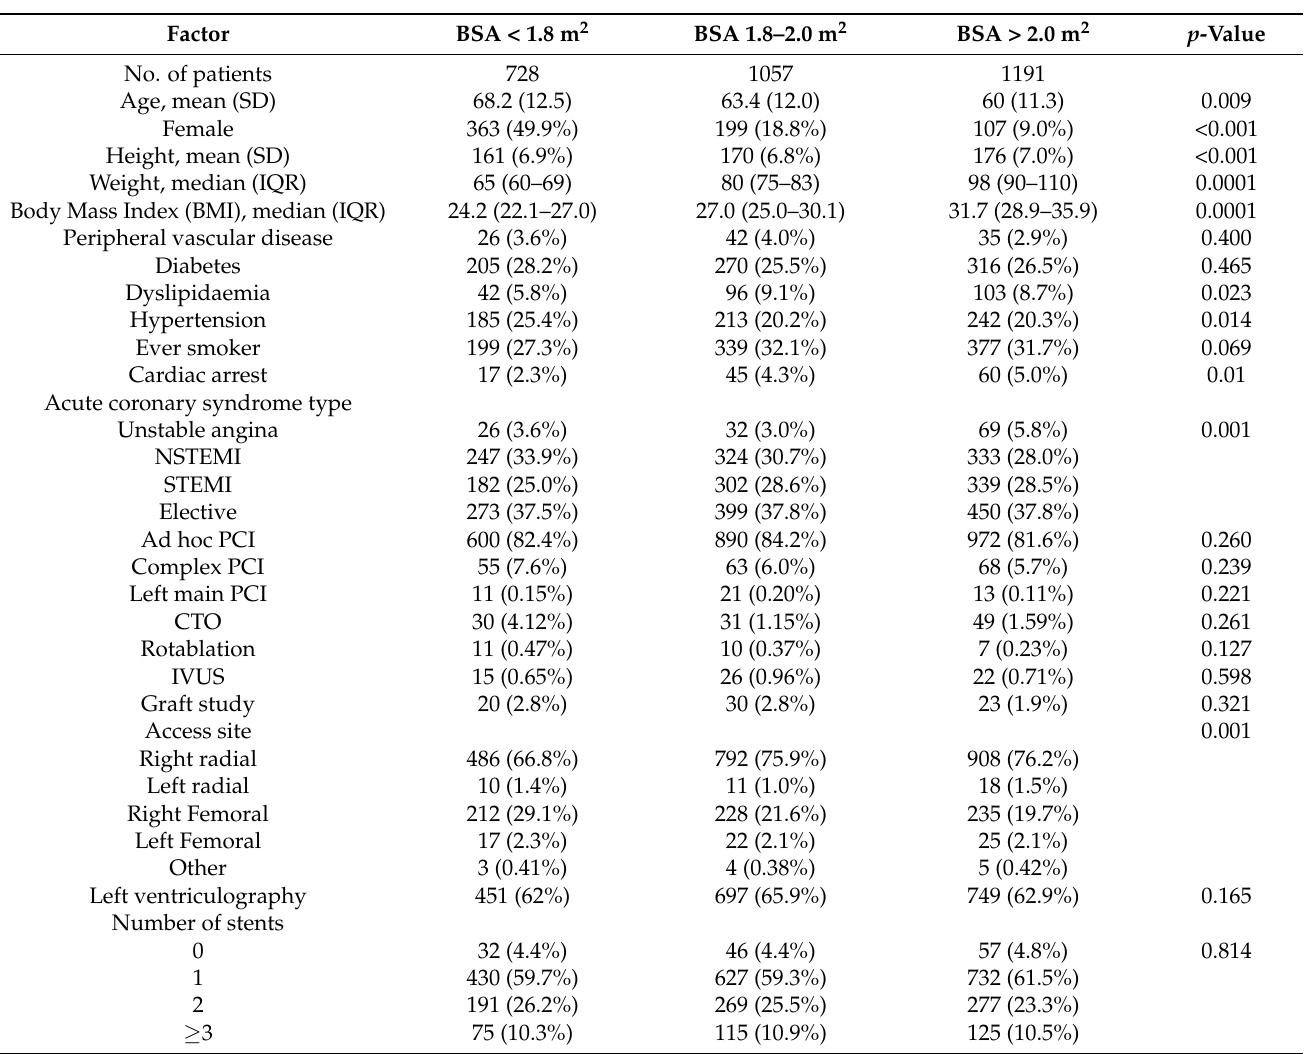
Table 2. Baseline characteristics for whole cohort, analysed by body surface area categories. Both patient and procedural characteristics are